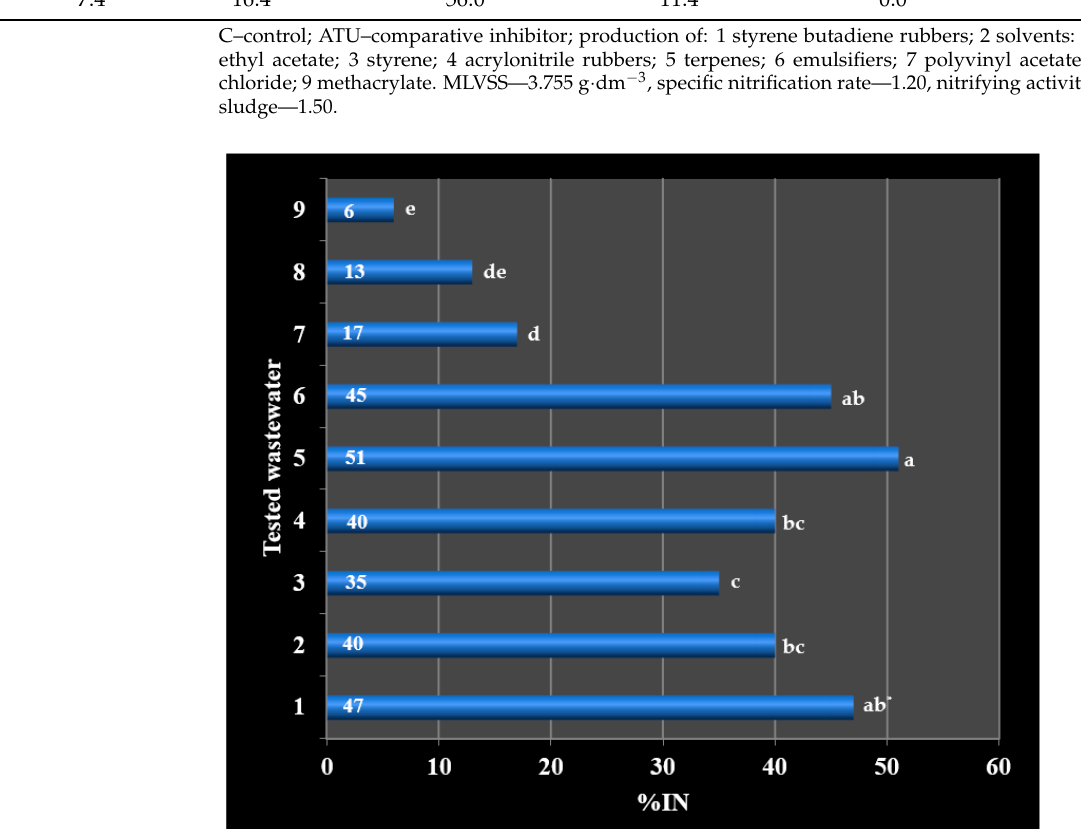
Figure 6. Influence of the filtering process on the percentage of nitrification inhibition. 1 styrene butadiene rubbers; 2 solvents: butyl acetate, ethyl acetate; 3 styrene; 4 acrylonitrile rubbers; 5 terpenes; 6 emulsifiers; 7 polyvinyl acetate; 8 polyvinyl chloride; 9 methacrylate. * Averages marked with the same letters are not significantly different by Tukey’s test ( α =